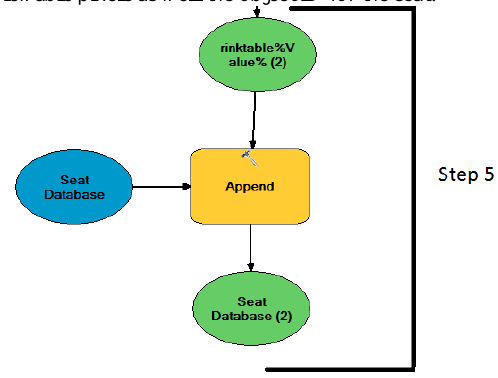
Figure 4: Step 3: index raster with object ID